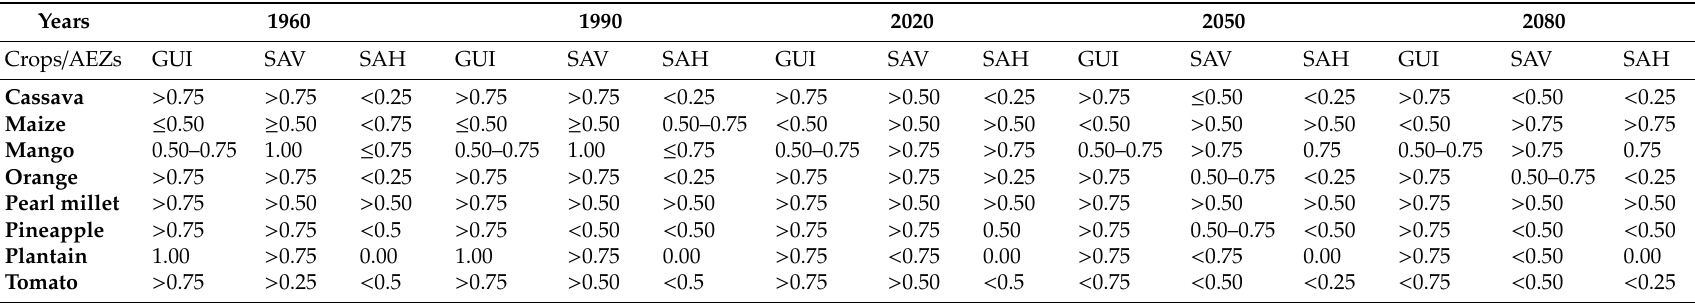
Table 3. Ecocrop simulated crop Suitability Index Value (SIV) for the eight (8) di ff erent crops across the three Agro-ecological zones (AEZs) of West